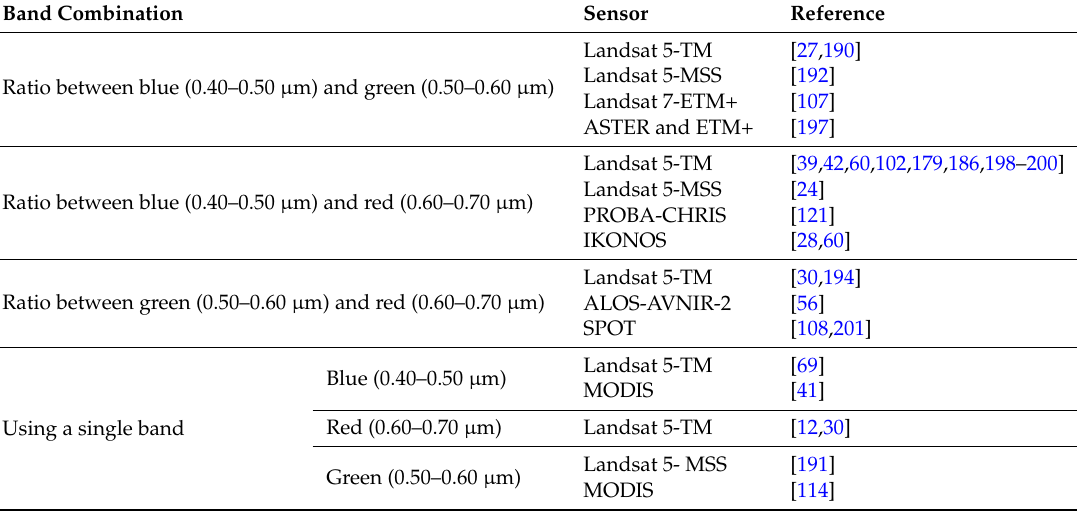
Table 7. Remotely measurements of SDD using various spectral bands and their